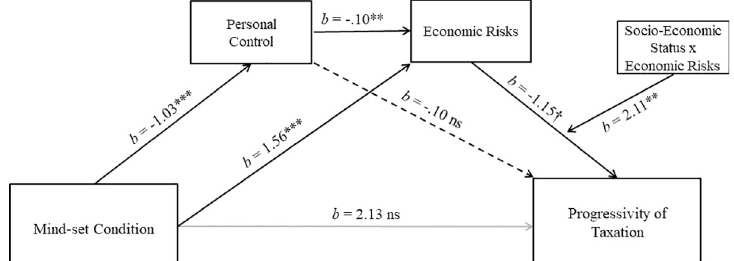
Fig 3. Study 2. Results of moderated mediation analysis testing the indirect effects of mind-set condition (0 = personal; 1 = collective) on progressivity of taxation via personal control and economic risks (as serial mediators). Note. N = 384. ��� p < .001, �� p < .01, � p < .05, † p <